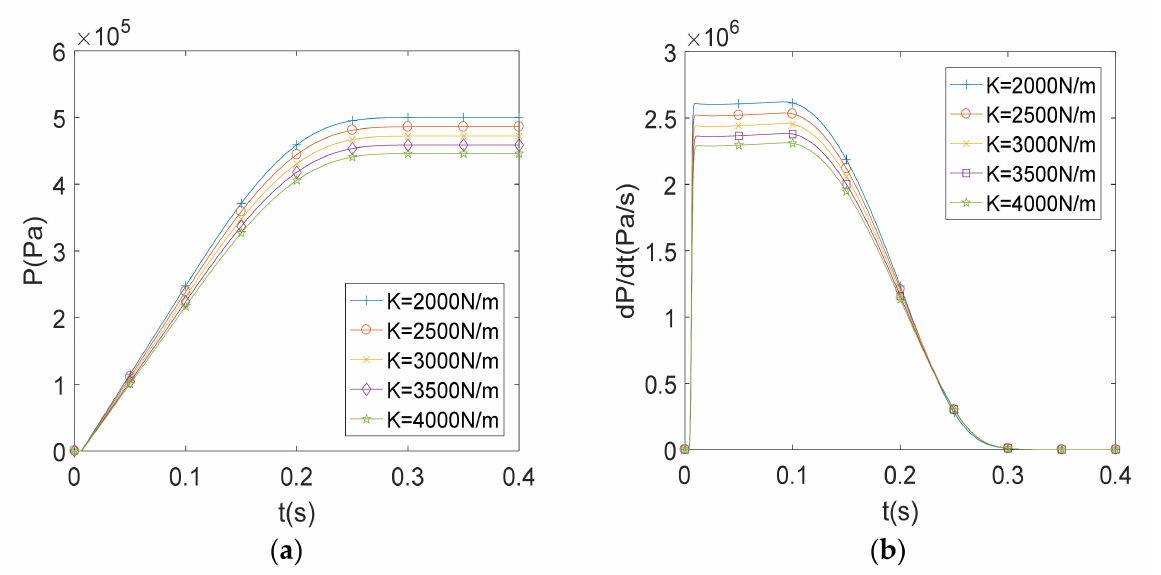
Figure 13. Influence of spring stiffness on pressure change rate: ( a ) pressure response; ( b ) pressure change rate